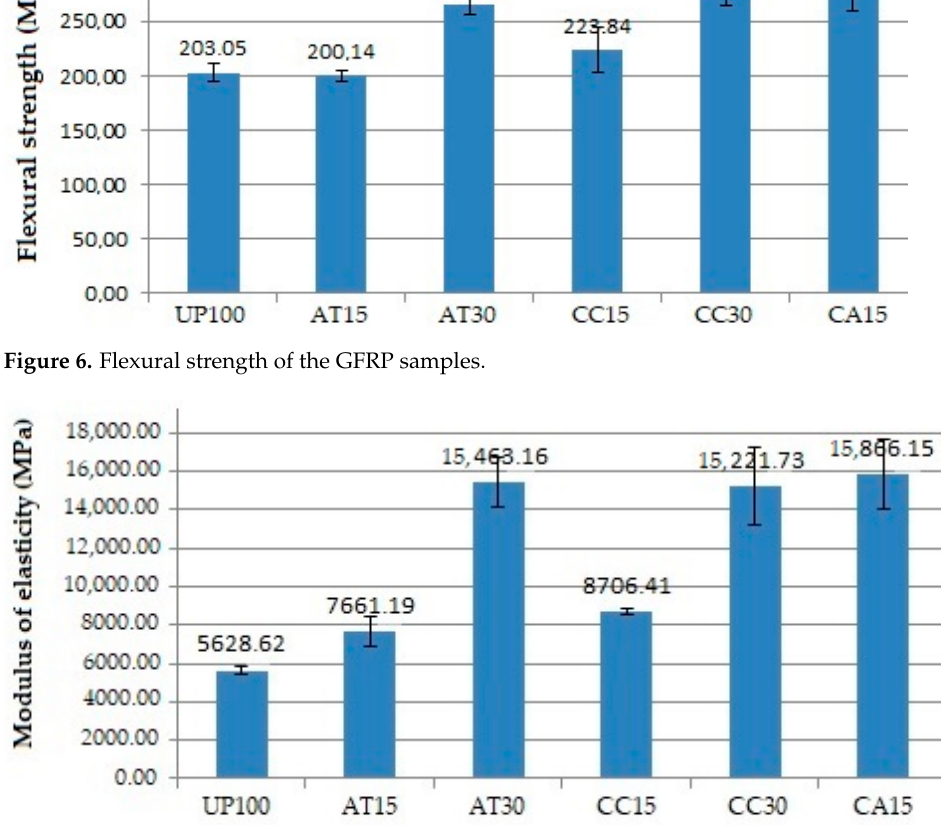
Figure 7. Modulus of elasticity of the GFRP samples.